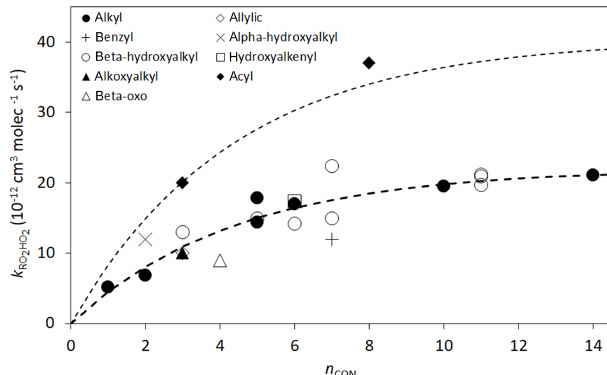
Figure 2. Rate coefficients for the reactions of various classes of RO 2 radicals with HO 2 as a function of n CON at 298K. The heavy broken line is the best fit to the data for alkyl and β -hydroxyalkyl RO 2 on the basis of the assumed function k = A( 1 − exp (Bn CON )) . The light broken line is the same function with the 298K value of k increased by a factor of 1.84 (see Sect.